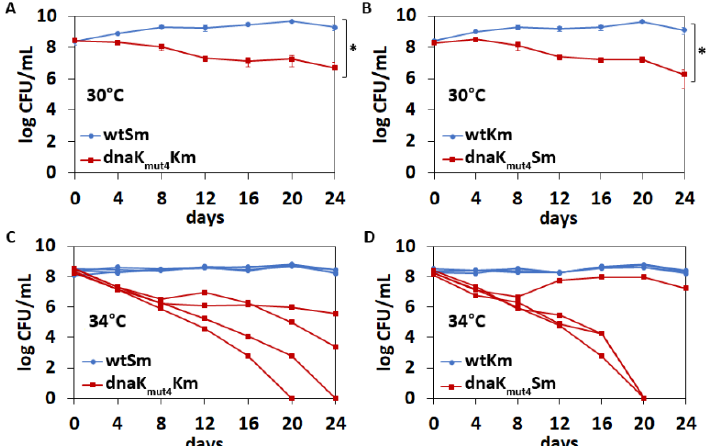
Figure 6. The negatively charged conserved motif in DnaK C -terminus is needed for competitive fitness of P. putida . Co-cultivation of P. putida wild-type and dnaK mut4 strains that are marked with an antibiotic resistance gene (streptomycin or kanamycin). Panels A and C represent data for wtSm: dnaK mut4 Km cocultivation mixtures and panels B and D for wtKm: dnaK mut4 Sm mixtures. Bacteria were grown in LB medium at 30 ◦ C or at 34 ◦ C, diluted into a fresh LB medium every 2 days and CFU/mL was measured every 4 days. Means of four independent co-cultures with standard deviations are presented for experiments at 30 ◦ C ( A , B ). For data obtained at 34 ◦ C ( C , D ), each independent co-culture is graphed. Two-way ANOVA test was used to evaluate the difference between two strains over all time points (* p < 10 − 16